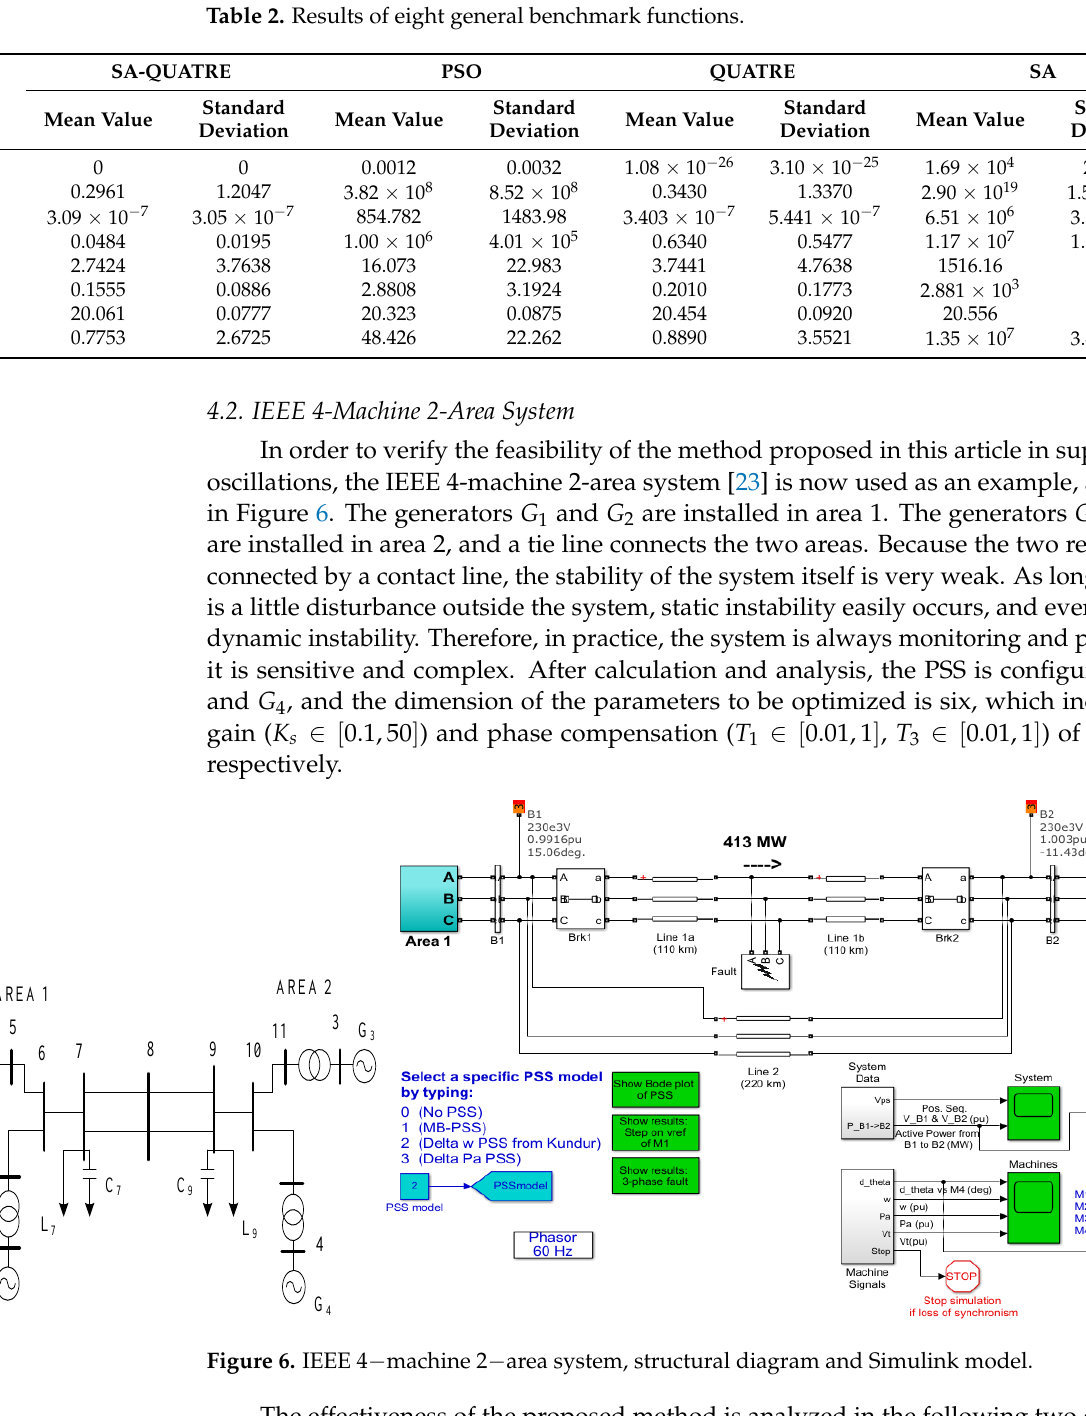
Table 2. R esults of eight general benchmark functions.